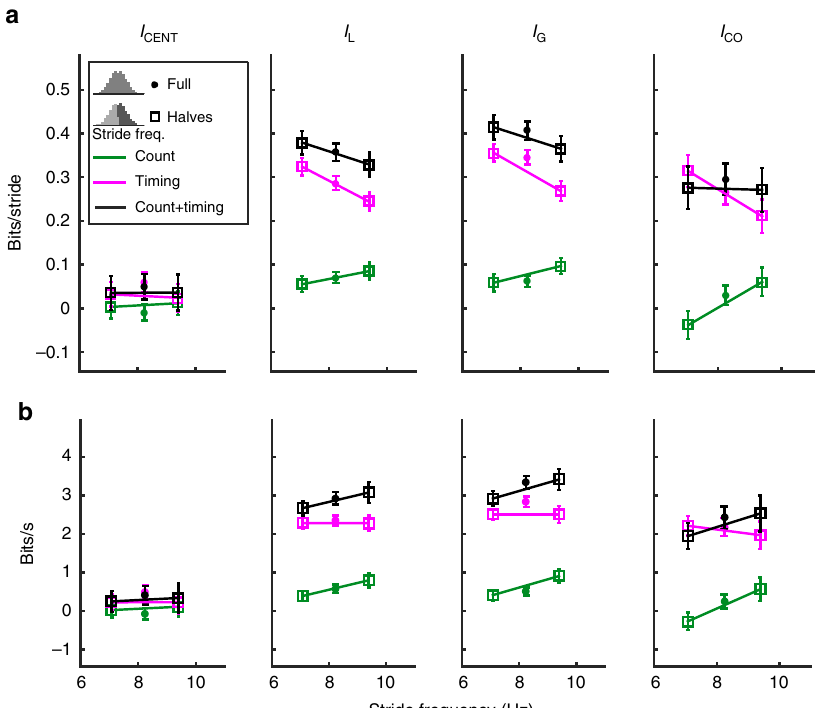
Fig. 4 Centralization and of fast versus slow cockroach strides. a When splitting the strides into a slow half and a fast half, I CENT remains unchanged when compared to the full set of strides. However, both local and global mutual information decrease equally, and this decrease is attributed to information in timing. I CO remains constant due to competing trends in timing and count. b Same as a only information is converted to a bits/second rate using the median stride frequency of each group. Though the information per stride decreases, the information per unit time